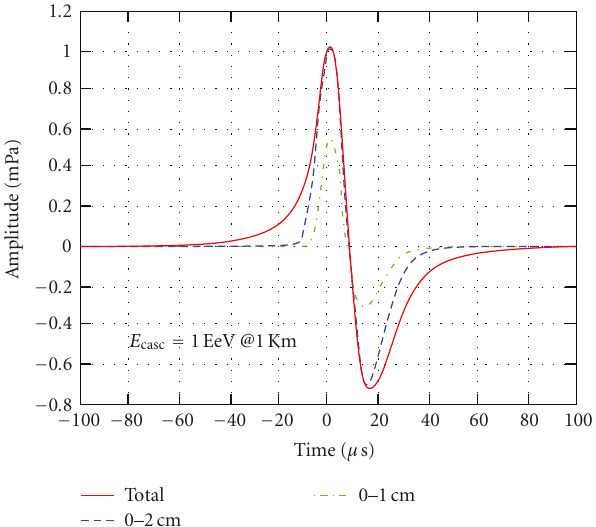
Figure 2: Simulated bipolar pressure pulse from a 10 18 eV hadronic cascade at a radial distance of 1km. Roughly half of the pressure pulse is produced within a radius of 1cm (dash-pointed line) of the cascade, whereas the energy distribution within a radius of 2cm (dashed line) is nearly completely responsible for the final signal shape (solid line). Figure adapted from [6].